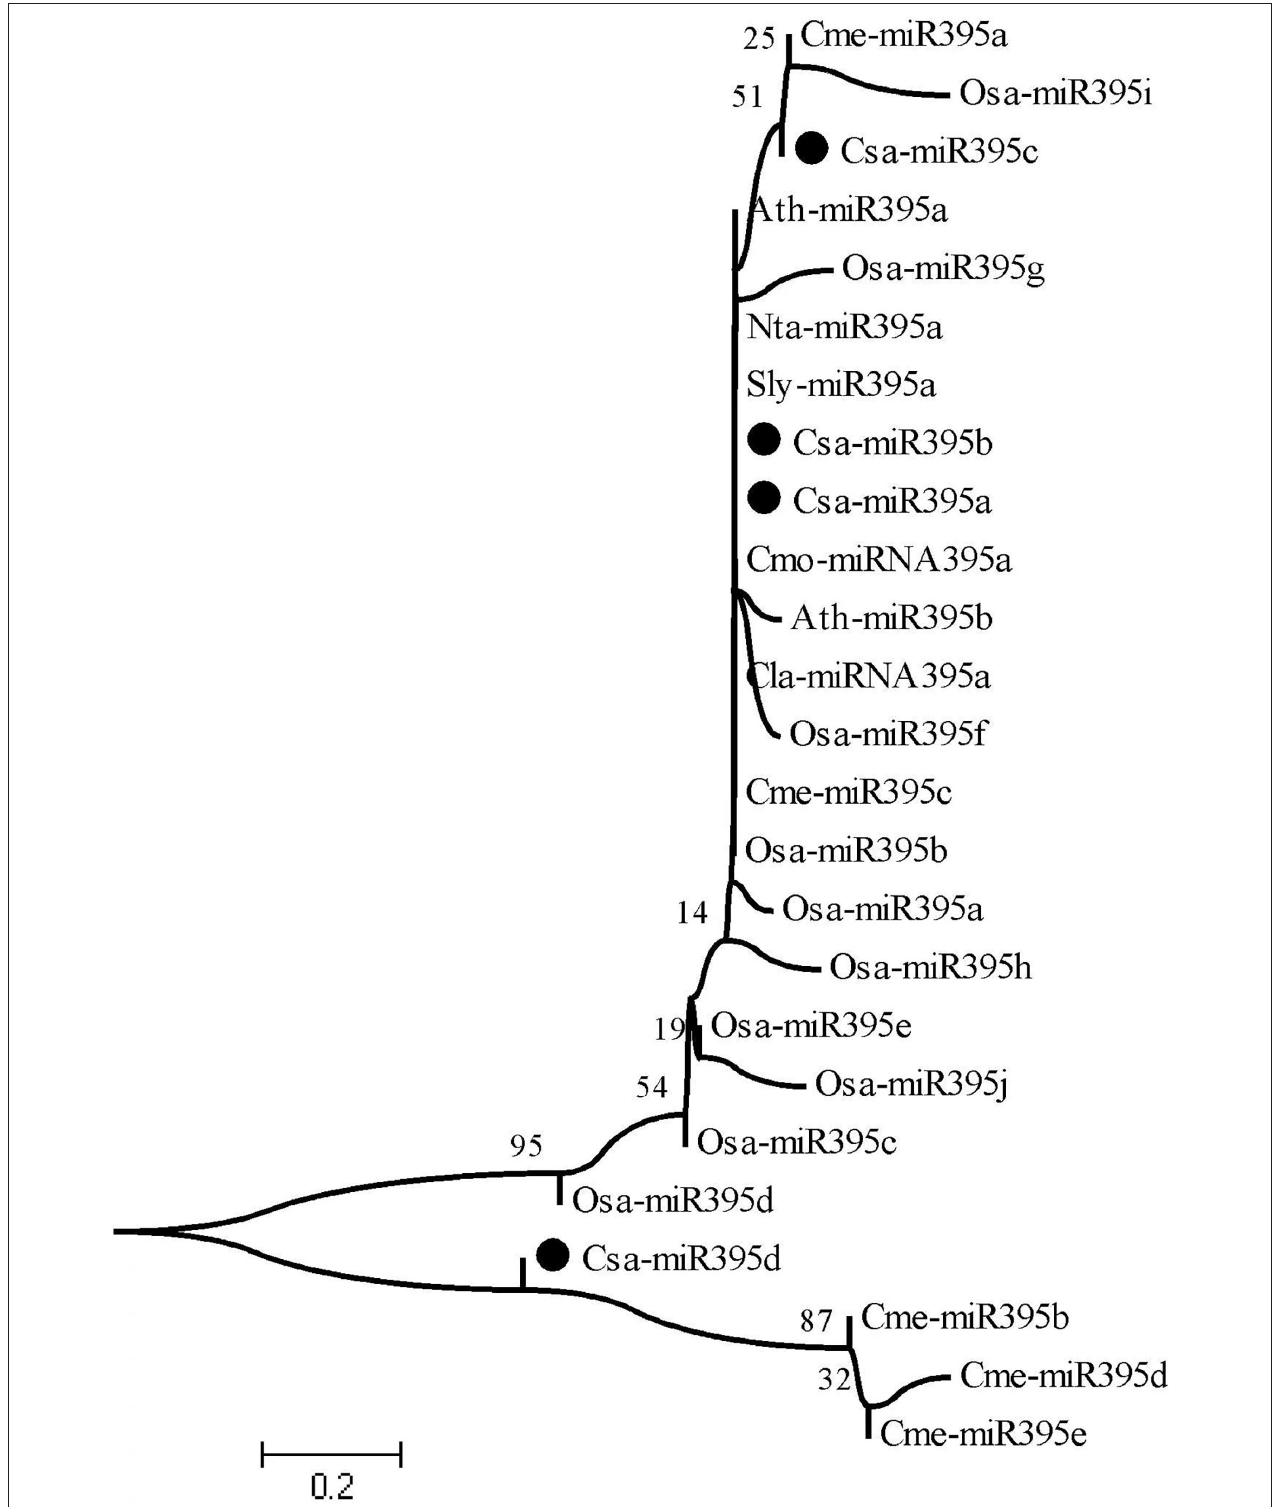
FIGURE 2 | Evolutionary relationship of miR395s. Csa, cucumber, Cme, melon, Ath, Arabidopsis , Osa, rice, Sly, tomato, Nta, tobacco, Cla, watermelon, Cmo, pumpkin.